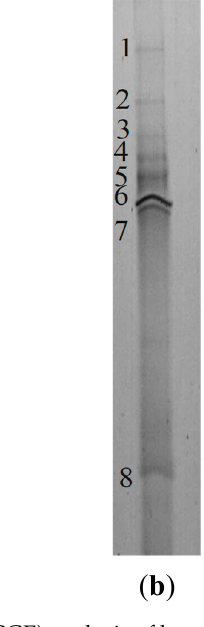
Figure 6. Denaturing gradient gel electrophoresis (DGGE) analysis of bacterial community structures from the methane fermentation systems under ( a ) mesophilic and ( b ) thermophilic